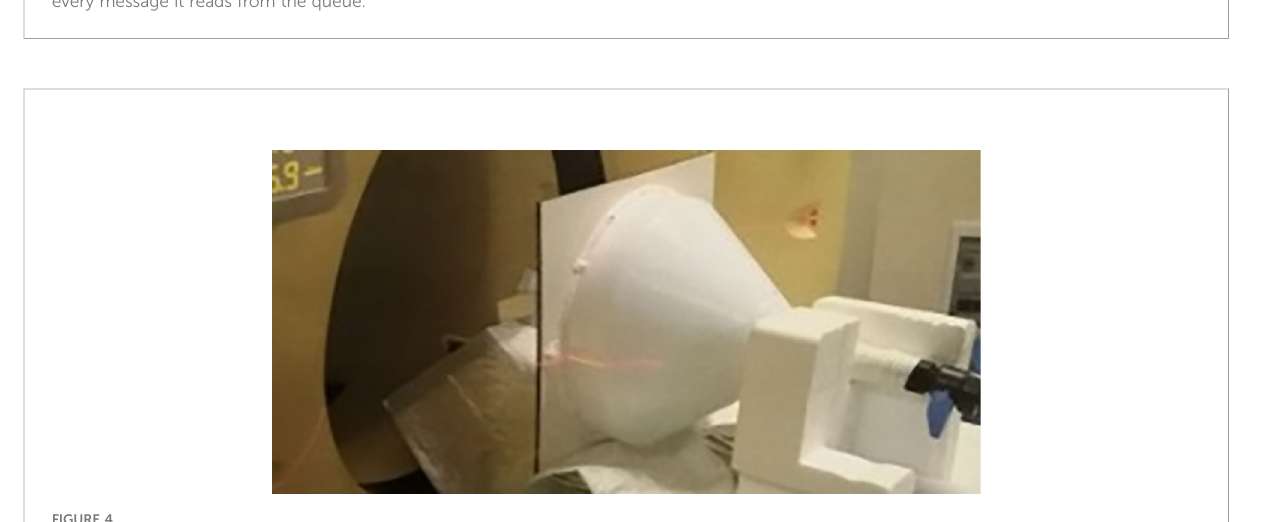
FIGURE 4 Our funnel phantom (plastic fi lled with water).